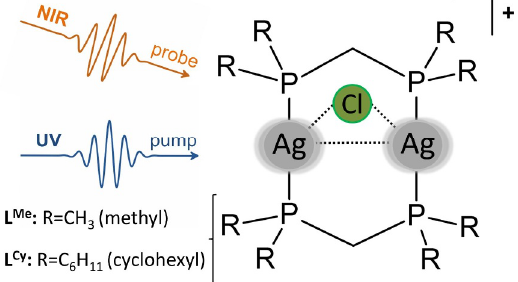
Fig. 1. Schematic structures of complexes [Ag 2 (Cl)(L Me ) 2 ] + , 1 + and [Ag 2 (Cl)(L Cy ) 2 ] + , 2 + , respectively (L Me = bis(di methyl phosphino)methane, L Cy = bis(di cyclohexyl phosphino)methane). For τ-PD experiment UV-pump (280 nm) and NIR-probe (1150 nm) pulses were